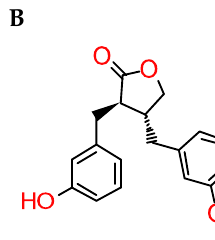
Table 8. Lignan content of oils (mg/100 g food) [18]. 130